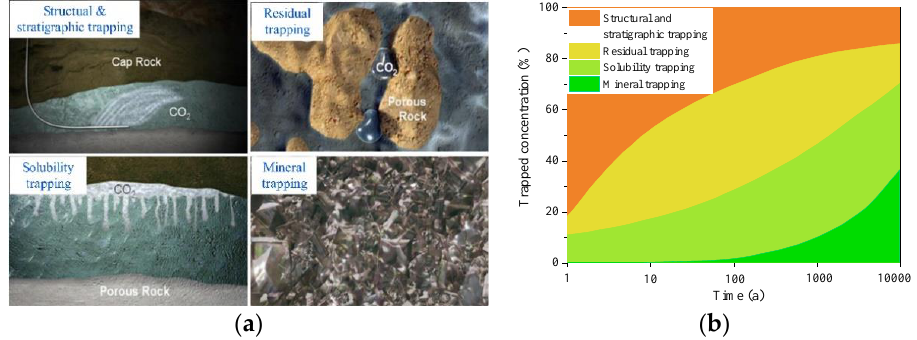
Figure 4. ( a ) The four main CO 2 trapping mechanisms [51]; ( b ) the contribution of four CO 2 trapping mechanisms with time (modified from [52]).